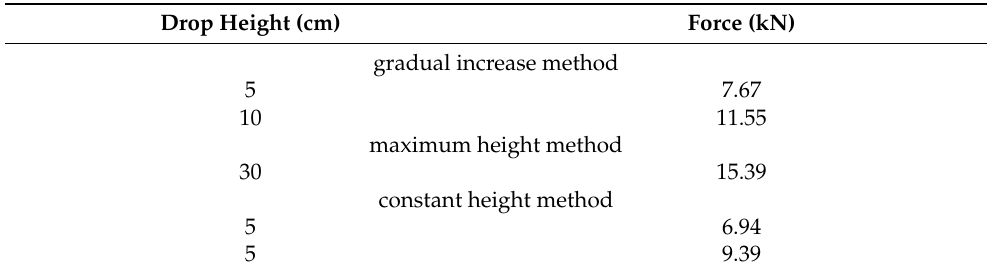
Table 2. Data from the masonry of autoclaved aerated concrete testing .